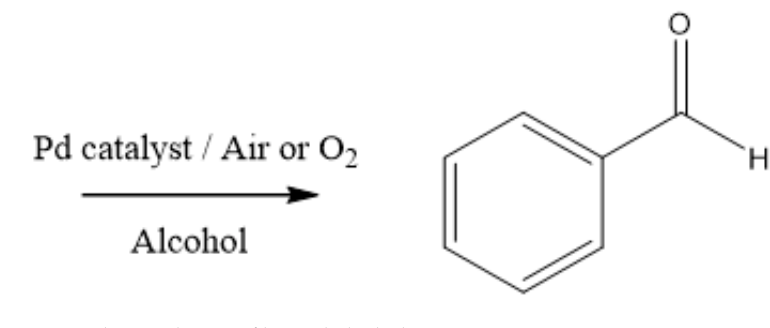
Figure 2. Aerobic oxidation of benzyl alcohol.